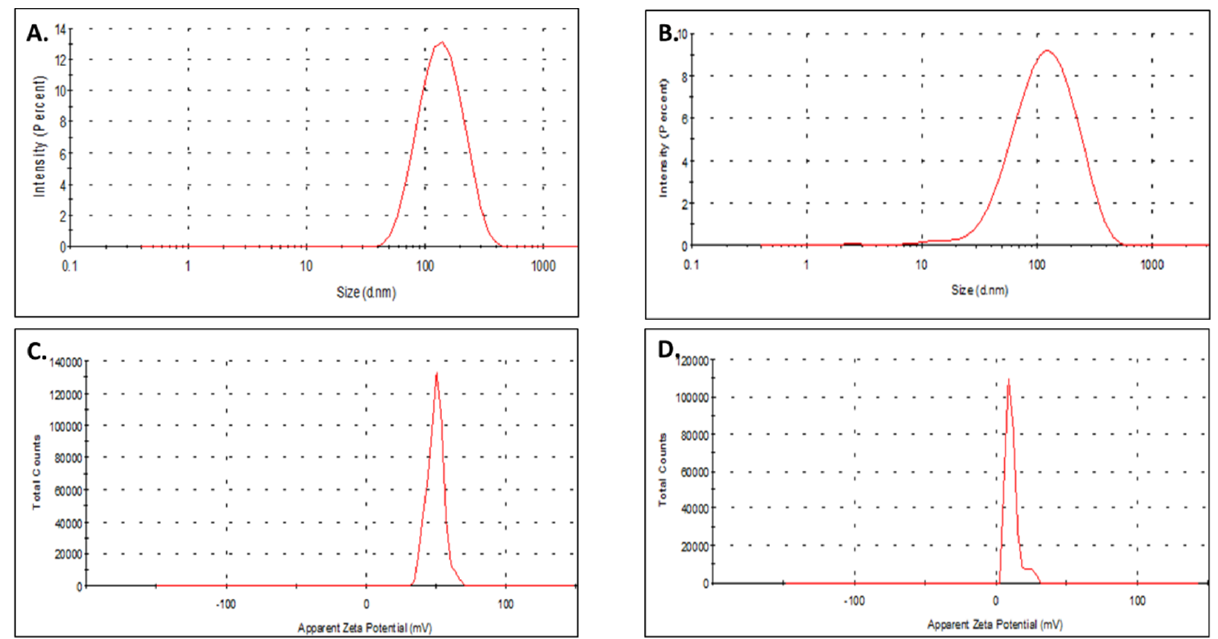
Figure 2. Representative size ( A , B ) and zeta potential ( C , D ) distribution for TS-MSN siCtrl ( A , C ) and TS-MSN siSurvivin ( B , D ). Mean values and SD are presented in Table 3. Table 3. Physicochemical characteristics of TS-MSN with control and anti-Survivin siRNAs.